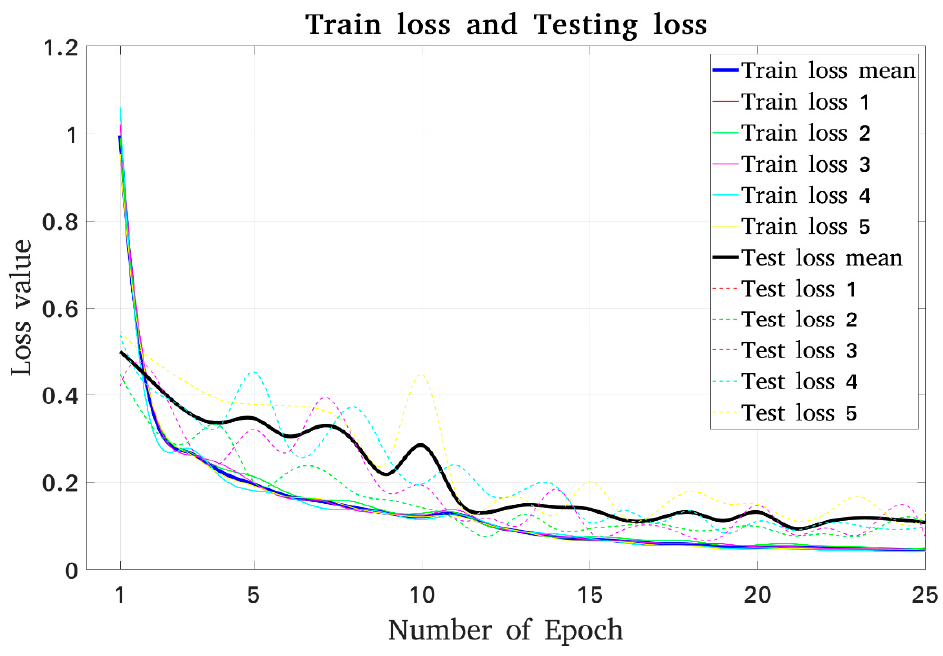
Figure 18. Loss graph for the deep learning model.